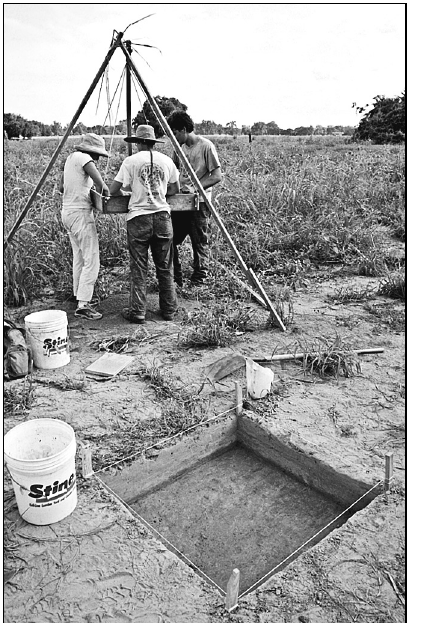
Figure 5 Excavation in progress at